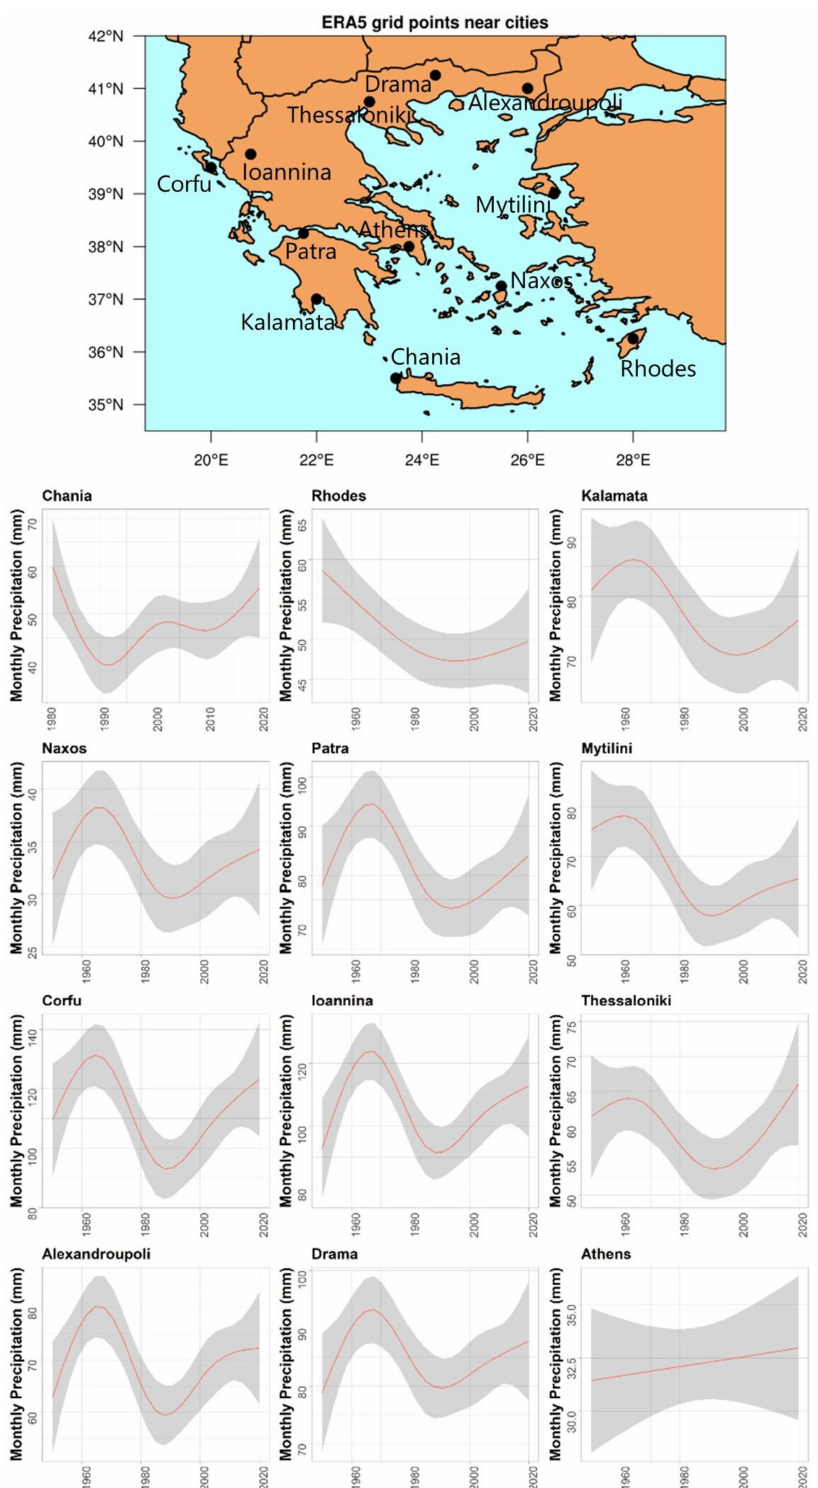
Figure 8. Fitted GAM trends to monthly precipitation (mm) for 12 selected grid points near Greek cities. Note that the 12 illustrated points are not exactly at the locations of cities. City names are used for convenience. The diagrams have different y -axis scale to better present the temporal variabilities of precipitation for each location. The shaded area represents the 95% confidence intervals. GAM results for the 11 of 12 cities illustrated are significant ( p ≤ 0.05), except for Athens in the last